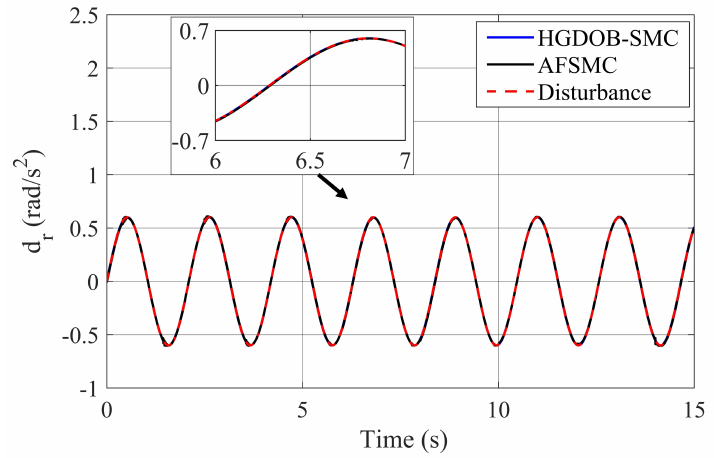
Figure 7. Disturbance d r and estimated value.